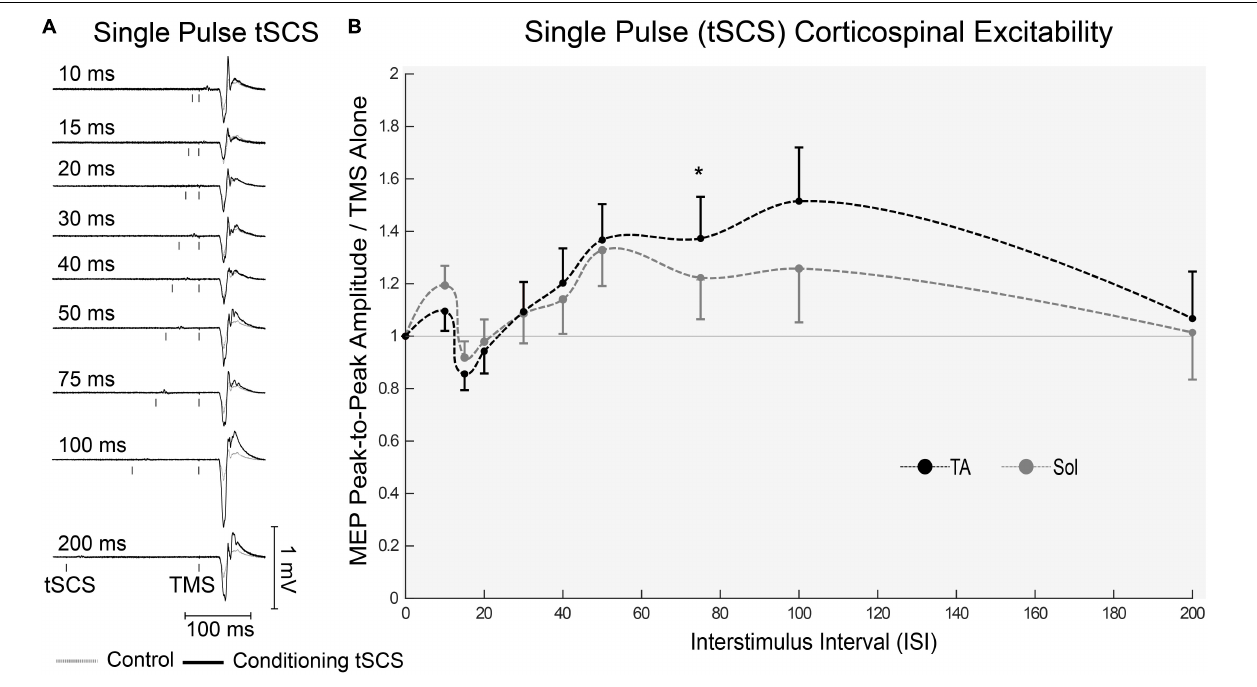
FIGURE 5 | Effects of single pulses of tSCS delivered at various ISIs on TMS evoked potentials in the lower limb. (A) Example waveform average (10-control, 4-conditioned trials) EMG trace responses evoked in the TA from one participant under control (gray dashed line) and tSCS conditioned (solid black line) at each ISIs. (B) Normalized peak-to-peak MEP amplitude in the TA (black dashed line) and Sol (gray dashed line) muscles at interstimulus intervals. Mean ± SEM; * P < 0.05.